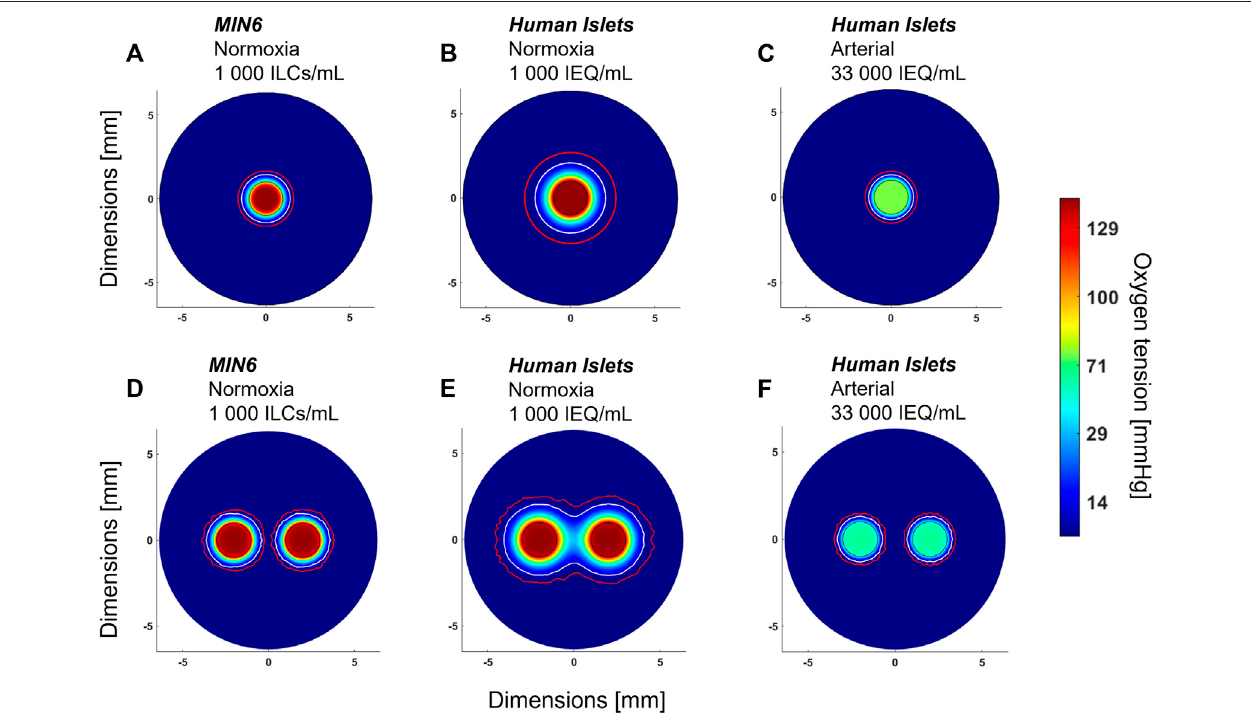
FIGURE 5 | Anticipated effect of device design parameters on oxygen distribution. All images shown are radial cross-sections taken at the middle of the device at steady state. (A) Mouse insulinoma 6 (MIN6) islet-like clusters (ILCs) encapsulated in 2% alginate at a concentration of 1,000 ILCs/mL gel and perfused with cell culture mediumundernormoxicconditions(140 mmHgO 2 ). (B) Sameparametersas (A) butsubstitutingMIN6ILCswithhumanisletsexhibitinganoxygenconsumptionrateof 202± 87 nmol/min/mg (Papaset al.,2007a). (C) Same parameters as (B) but celldensity increasedtoatherapeuticdose of600,000IEQ per deviceand perfused atanarterialoxygentension(76 mmHgO 2 )(Buderetal.,2013). (D) Sameparametersas (A) withanarrangementoftwoperfusionchannels,each2 mmindiameterand spaced 2 mm apart. (E) Same parameters as (B) with an arrangement of two perfusion channels. (F) Same parameters as (C) with an arrangement of two perfusion channels. In each panel, a white contour represents an oxygen tension of 7 mmHg and a red contour represents 0.1 mmHg O 2 . The colour legend indicates oxygen tension in mmHg O 2 . Islet equivalent, IEQ = islet of diameter 150